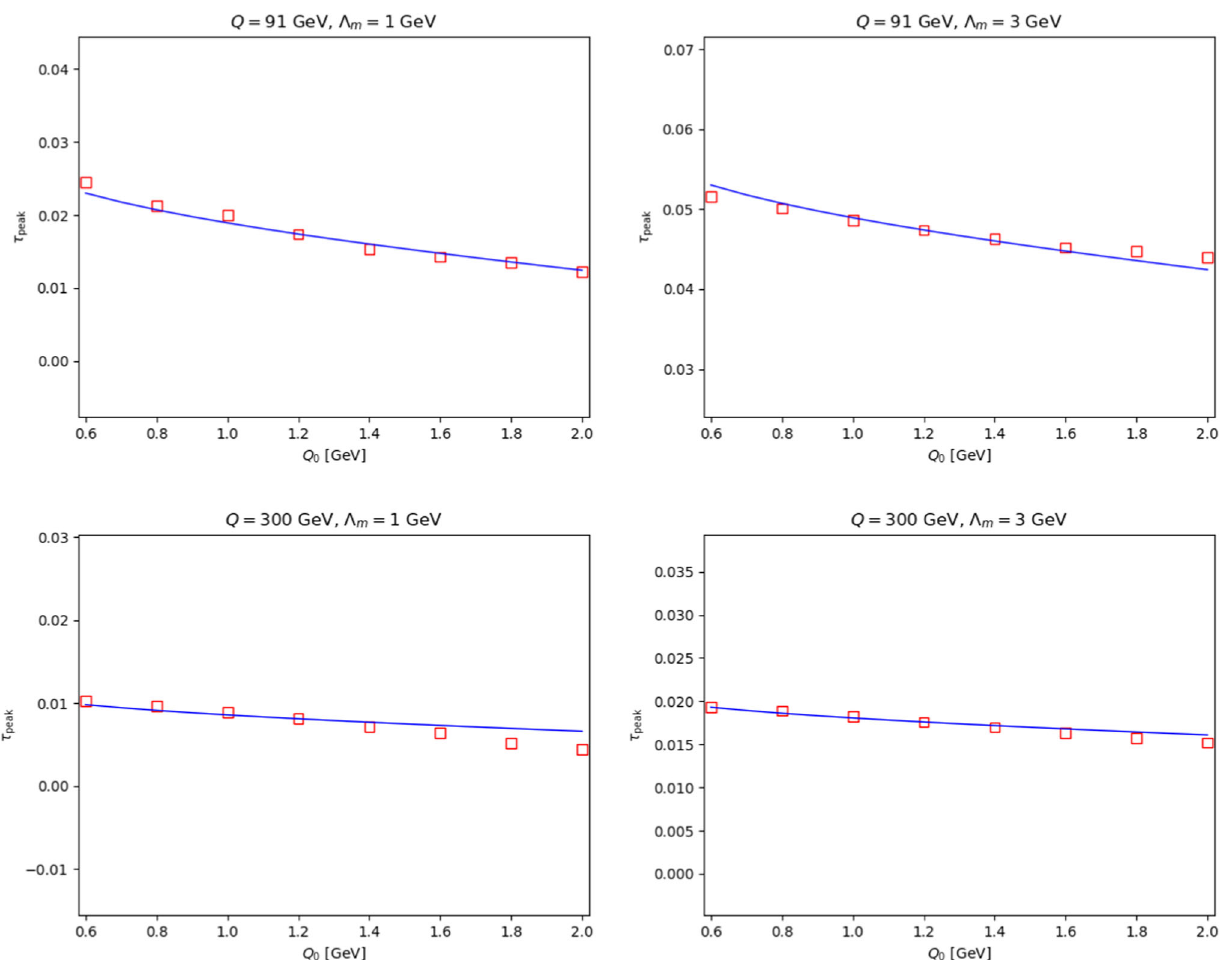
Fig. 3 Position of the peak of the thrust distribution as a function right). he blue solid line depicts the result of the analytical computation of the shower cutoff Q 0 . Displayed are the plots for Q = m Z with while the red squares represent the data points from the parton shower (cid:3) = 1GeV (upper left) and (cid:3) = 3GeV (upper right) as well as simulation m m Q = 300GeV with (cid:3) m = 1GeV (lower left) and (cid:3) m = 3GeV (lower